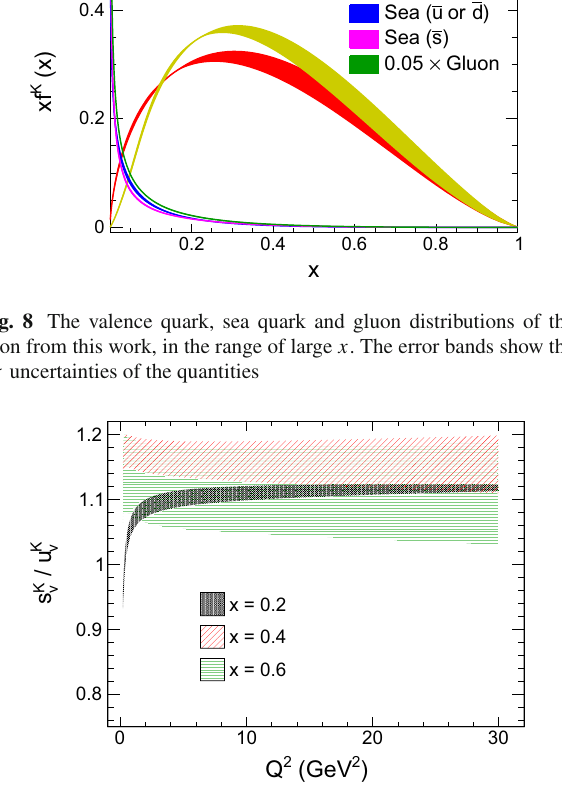
nents α are around -0.2 for the sea quark distributions; And the exponents α are around -0.25 for the gluon